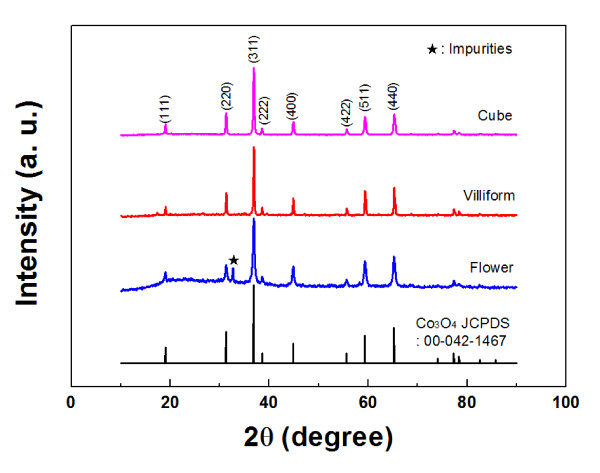
XRD patterns of the Co3O4 nanoparticles and reference Co3O4.